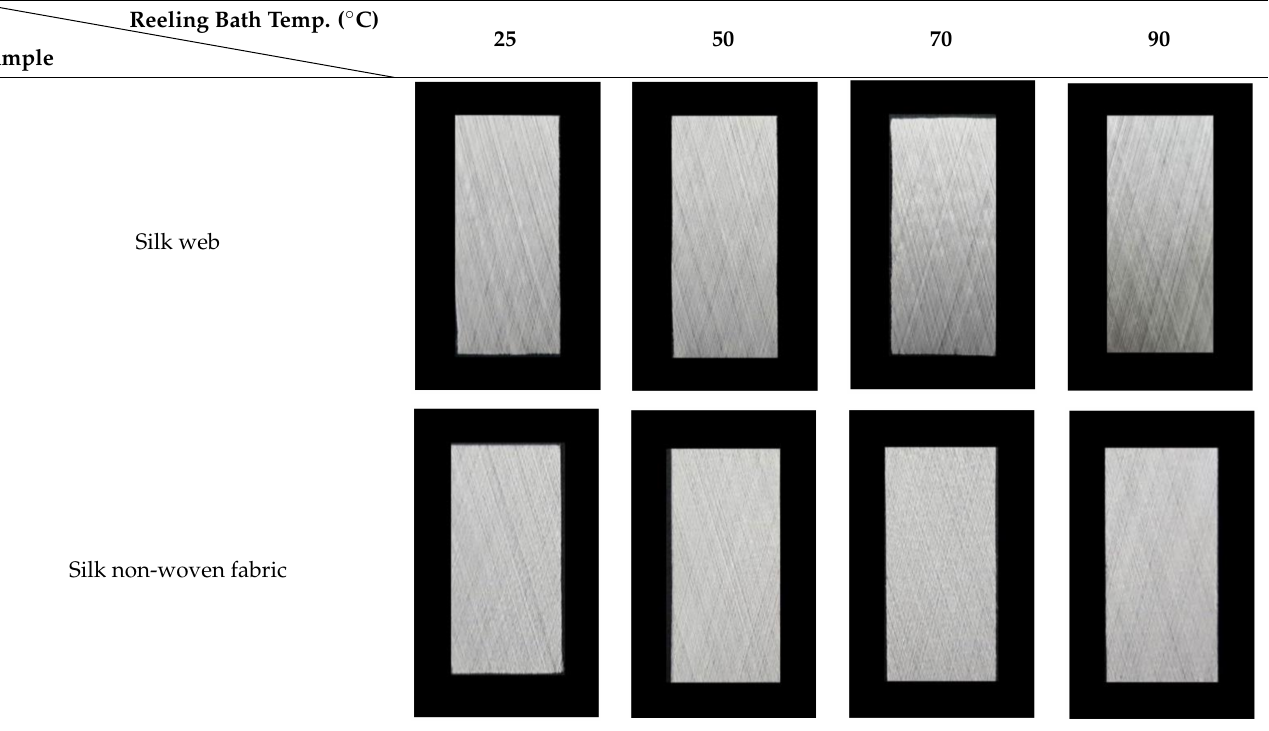
Table 3. Photographs of 20 mm (width) × 50 mm (height) silk web (untreated) and silk non-woven fabrics (hot-pressed silk web) prepared at various reeling bath temperatures. Reeling velocity was 39.2